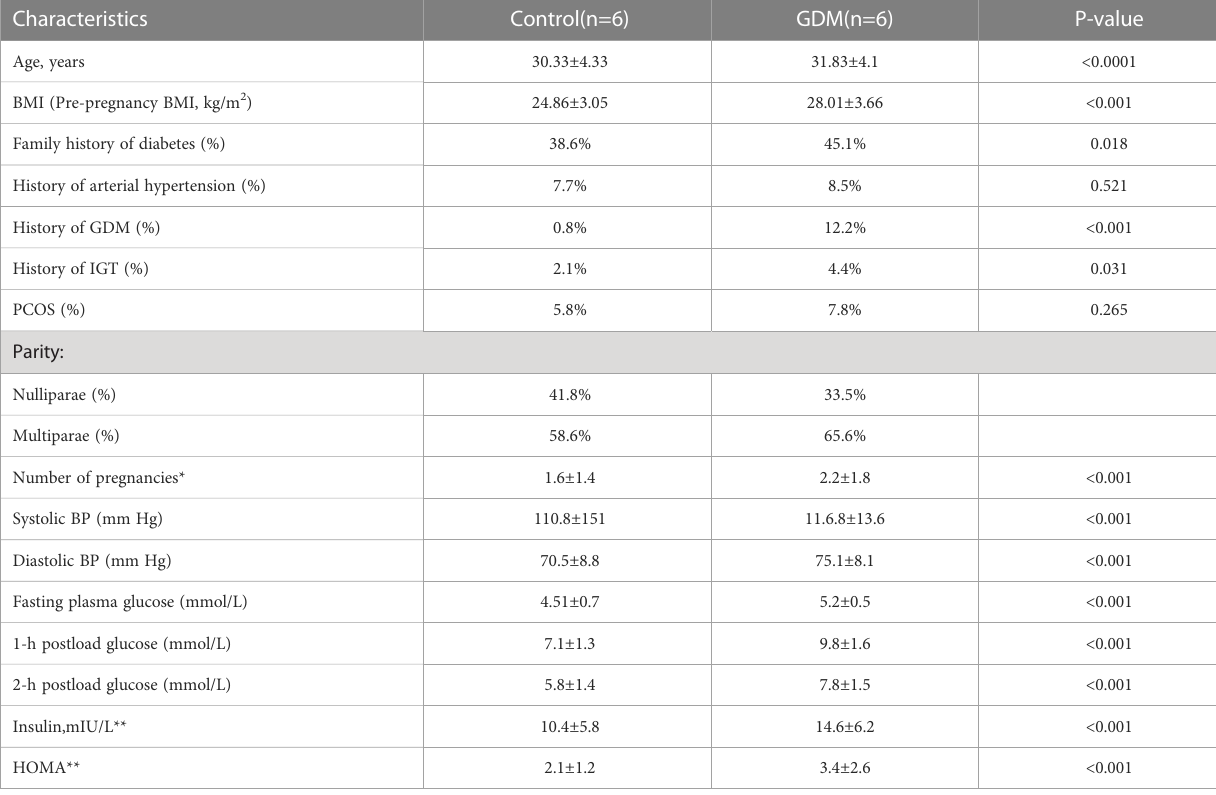
TABLE 1 Clinical information of participator with or without